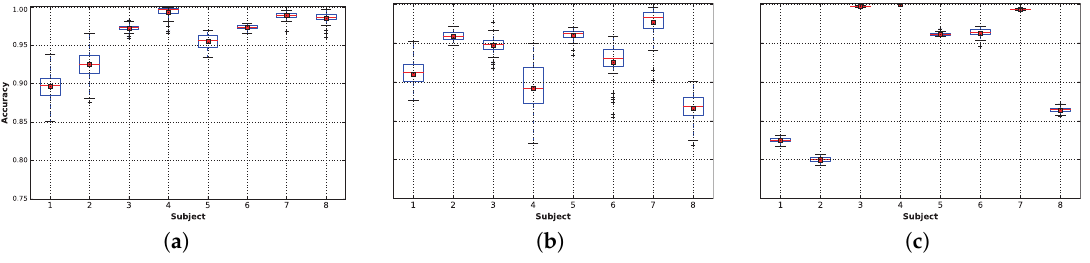
Figure 7. Distribution of accuracy over the test set for each subject, for the outperforming classifiers, using 5% of the training data. Each distribution results from the execution of 50 runs. ( a ) Extra trees; ( b ) DNN 1L; ( c )